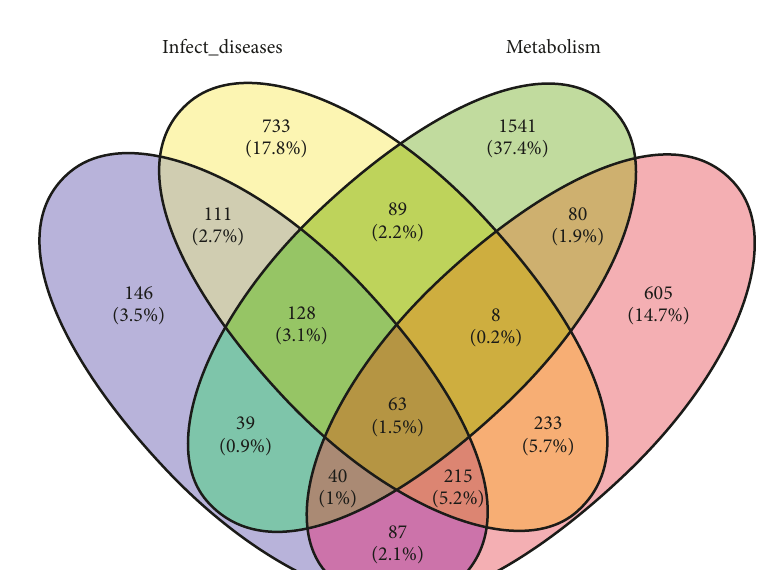
Figure 5: List of KEGG